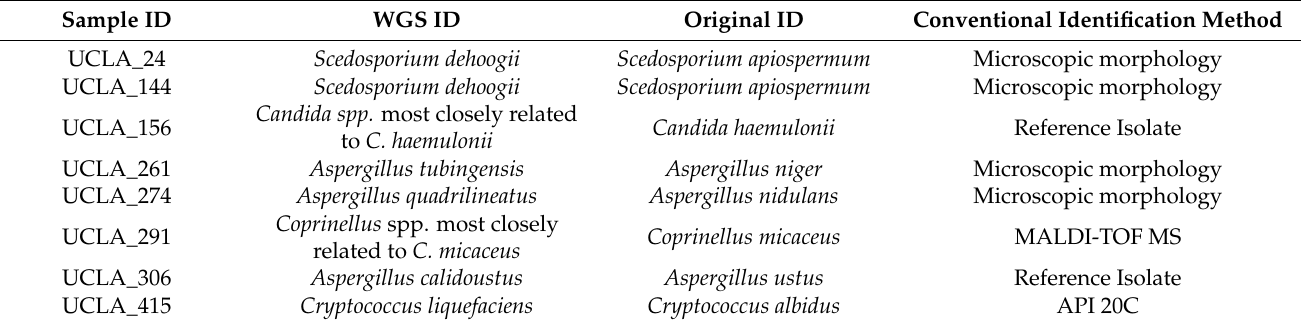
Table 3. List of Discordant